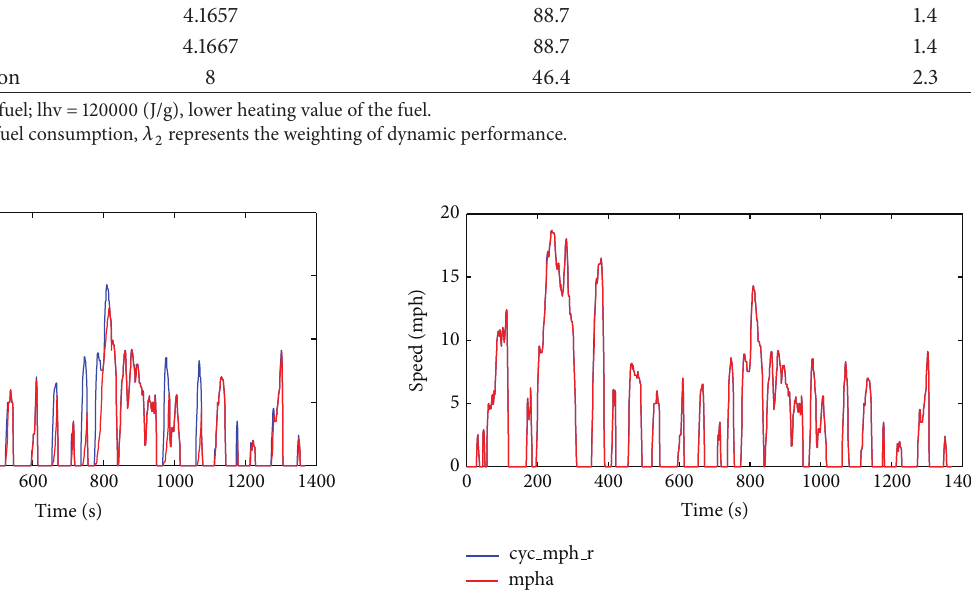
Figure 8: 𝜆 1 = 0.6 , 𝜆 2 = 0.4 , the speed of simulation & drive cycle.